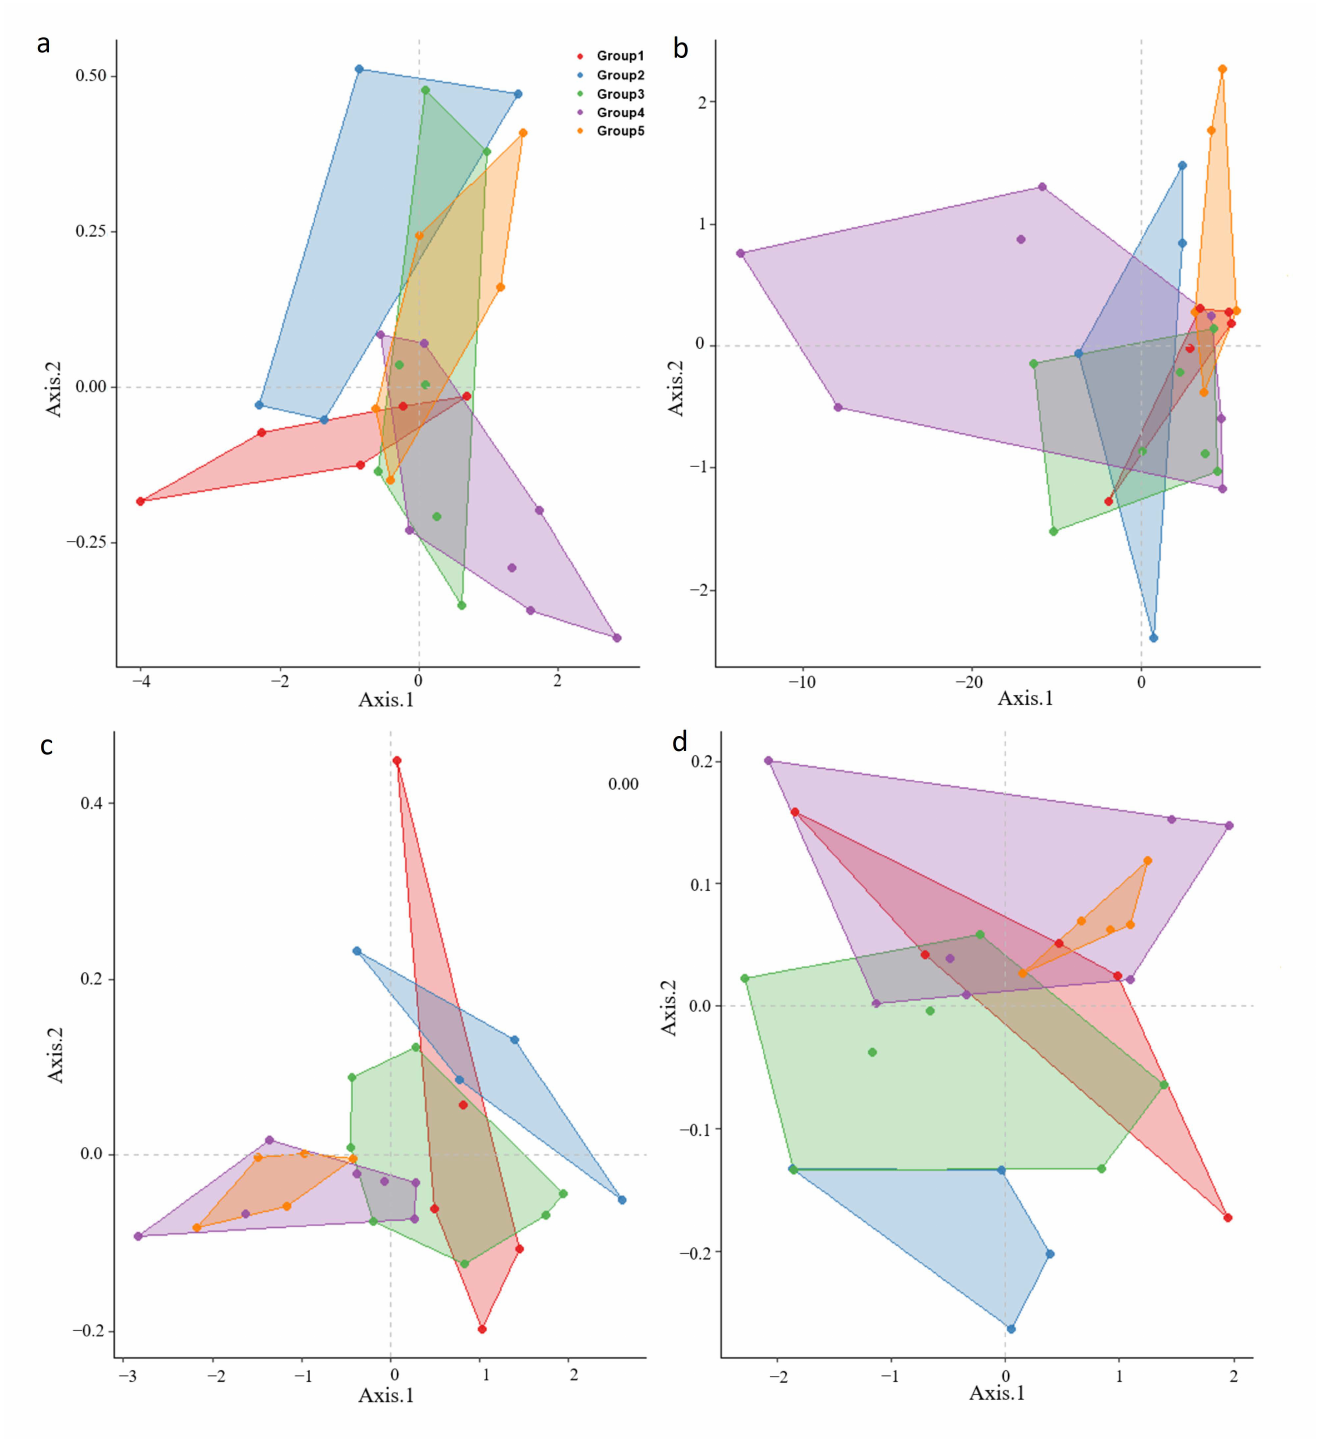
Figure 5. Metric multidimensional scaling analysis (MDS) of the spectral data for ( a ) leaf hyperspectral measurement, ( b ) canopy hyperspectral measurement, ( c ) early multispectral measurement and ( d ) late multispectral measurement (via metric dimensional scaling into k = 5 dimensions), with boundaries indicating the use of alpha